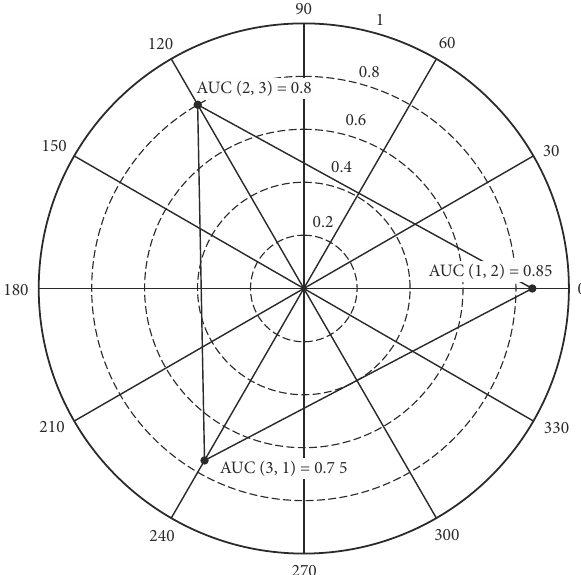
Figure 3. AUC polar diagram for three